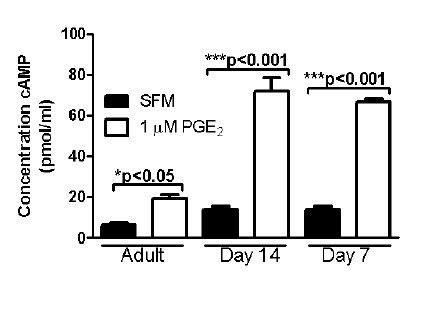
Elevated cAMP and skewed PDE isoform expression in neonatal macrophages. AMs were harvested from adult ((~10 weeks old) and young (day 7 and 14) rats and allowed to adhere overnight. A. AMs were stimulated with media or 1 μM PGE2 for 20 min before lysing the cells. Intracellular cAMP levels were measured in the whole cell lysate by specific EIA. For cAMP assay, data shown are representative of three individual experiments at least in preformed in duplicate. B. RNA was extracted from the cells, converted to cDNA and the relative expression of each of the PDE3 and PDE4 isoforms was determined using semi-quantitative real-time PCR. For real time PCR experiments, data represents mean ± SEM of pooled samples from 3 independent experiments. (*p < 0.05 and ***p < 0.001 when compared to the unstimulated samples (cAMP assay) and compared to adult AMs (real time PCR)).